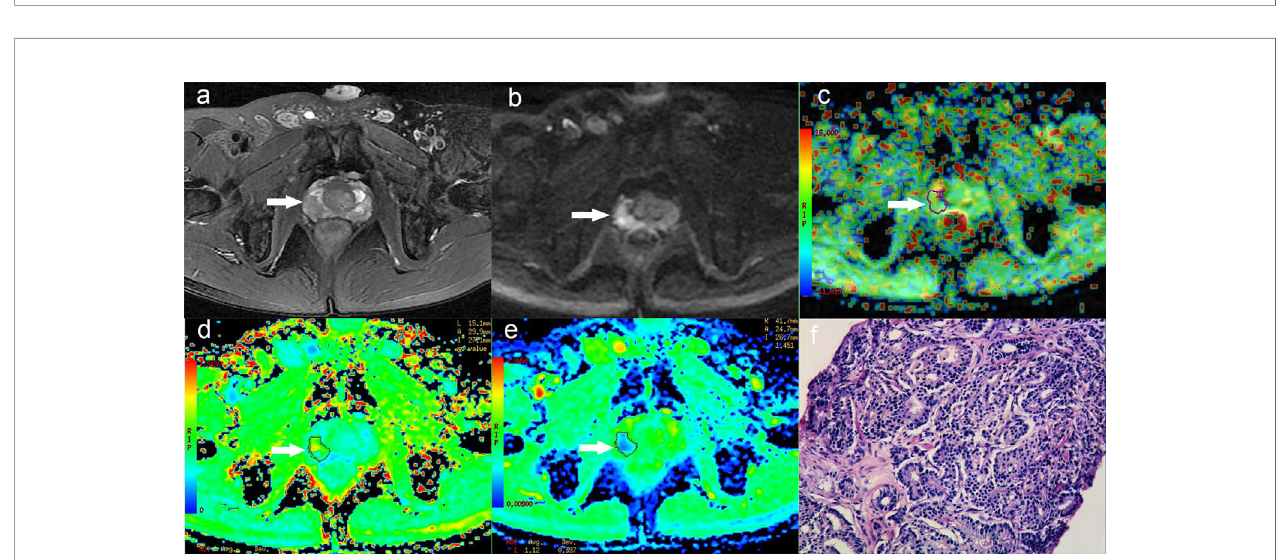
FIGURE 3 | A 58-year-old man with PCa in right peripheral zone, GS is 8. (A) T2-weighted image shows hypointense signal in the lesion, (B) Diffusion-weighted imaging indicates hyperintense signal, (C) APT pseudo-colored map shows yellow-green pseudocolor in the lesion, (D) Mean kurtosis pseudo-colored map indicates